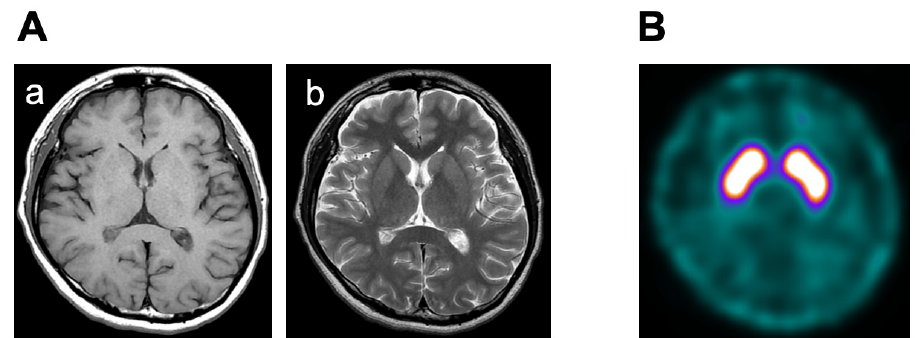
Figure 1. A : Cranial magnetic resonance imaging shows no abnormality in (a) T1 and (b) T2 axial sequences. B : Transverse dopamine transporter image with 123 I-β-CIT (2β-carbomethoxy-3β-(4-iodophenyl)tropane) single-photon emission computed tomography demonstrates normal binding of radioligand in both caudate nuclei and